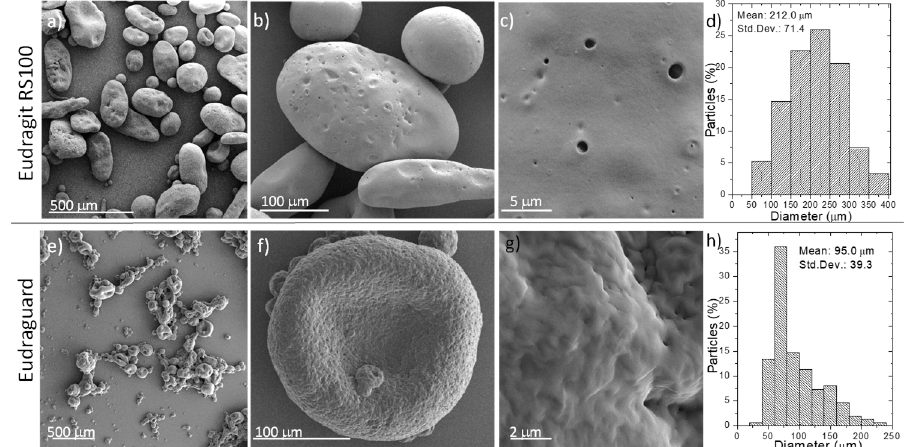
Figure 4. SEM micrographs ( a – c , e – g ) with different magnifications and particle size distribution histograms ( d , h ) (N = 150) of Eudragit RS 100 ( a – d ) and Eudraguard ( e – h ) microparticles loaded with Lactobacillus acidophilus . Std. Dev. = Standard Deviation.